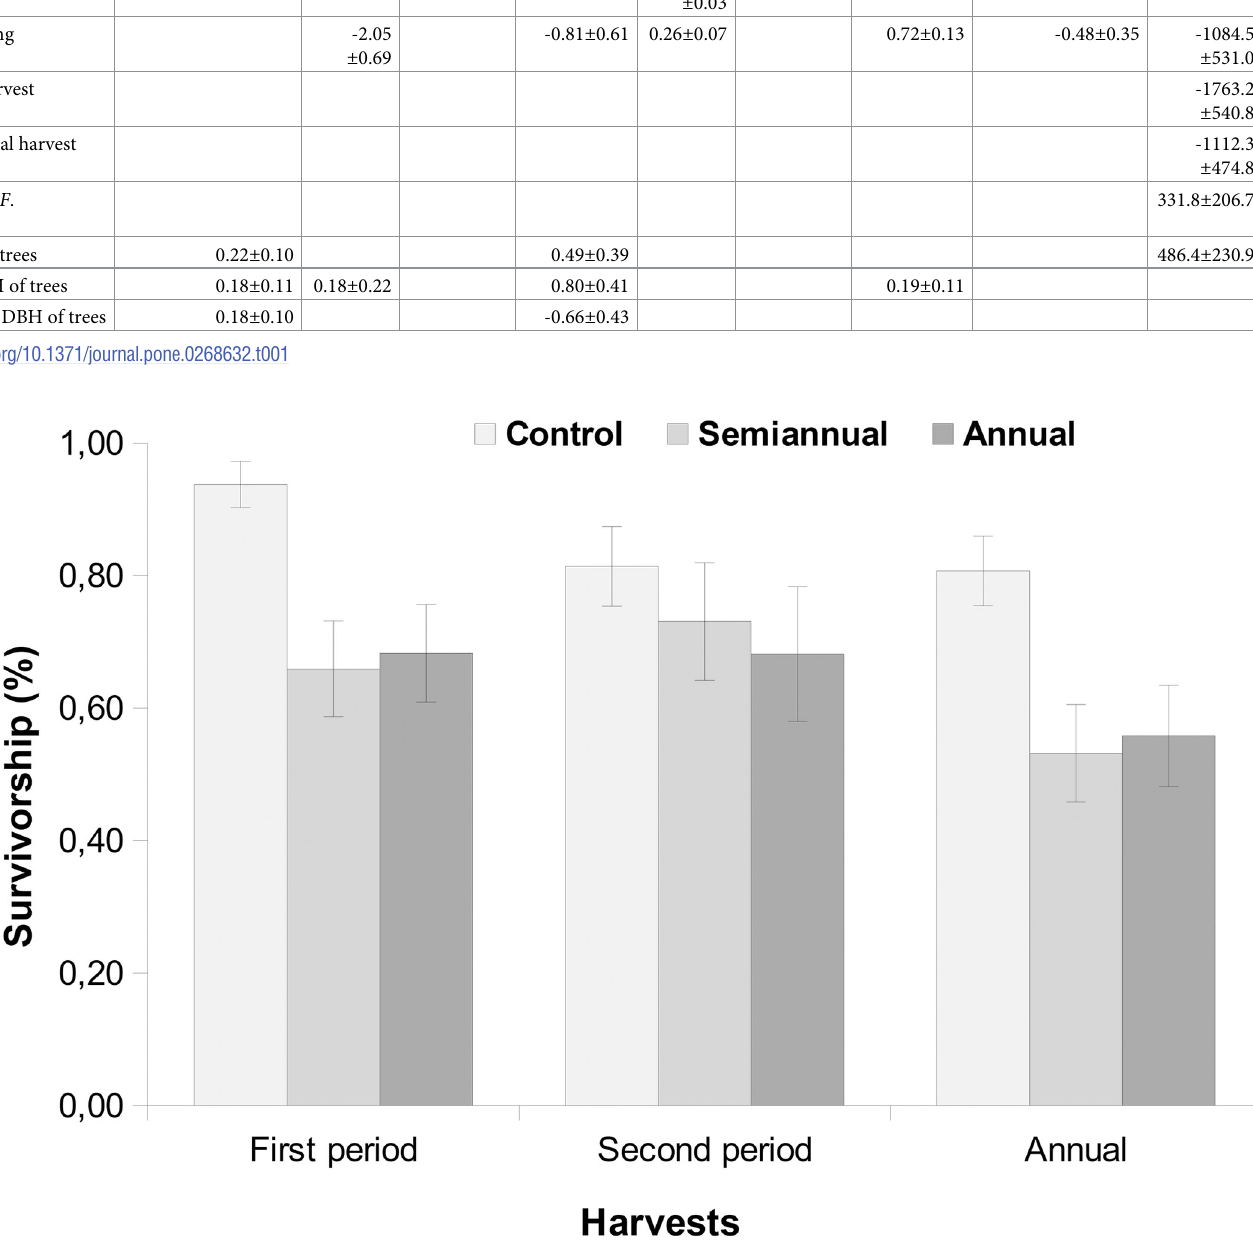
Fig 2. Survivorship of Forsteronia glabrescens (mean ± standard error) in two harvesting periods of six-months each and after one year, comparing stems unharvested and submitted to harvesting once and twice a year.